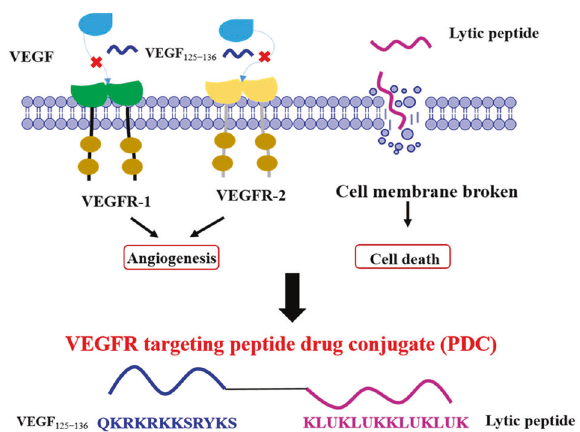
Fig. 1 The design of QR-KLU peptide conjugate. A lytic peptide (KLU) was conjugated with VEGFR peptide ligand (QR), called